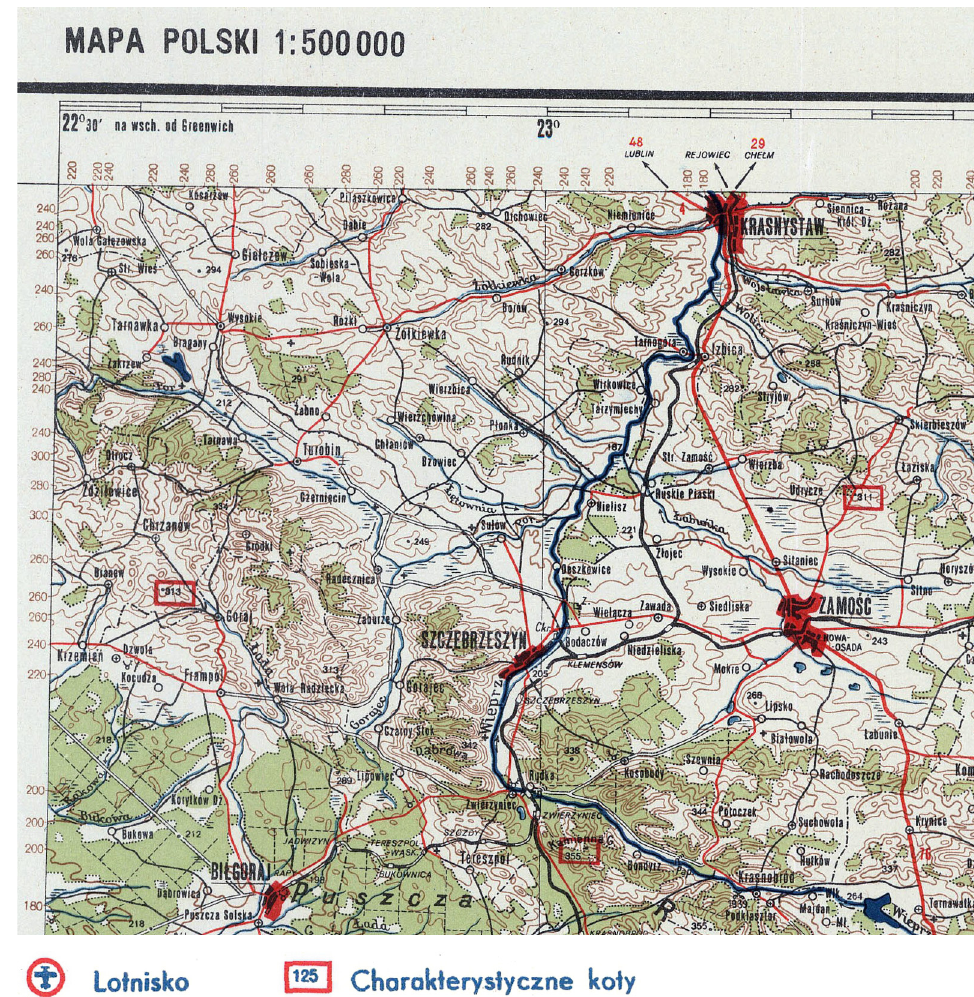
Fig. 11. Part of an aeronautical chart at the scale of 1:500,000, published by the Military Geographical